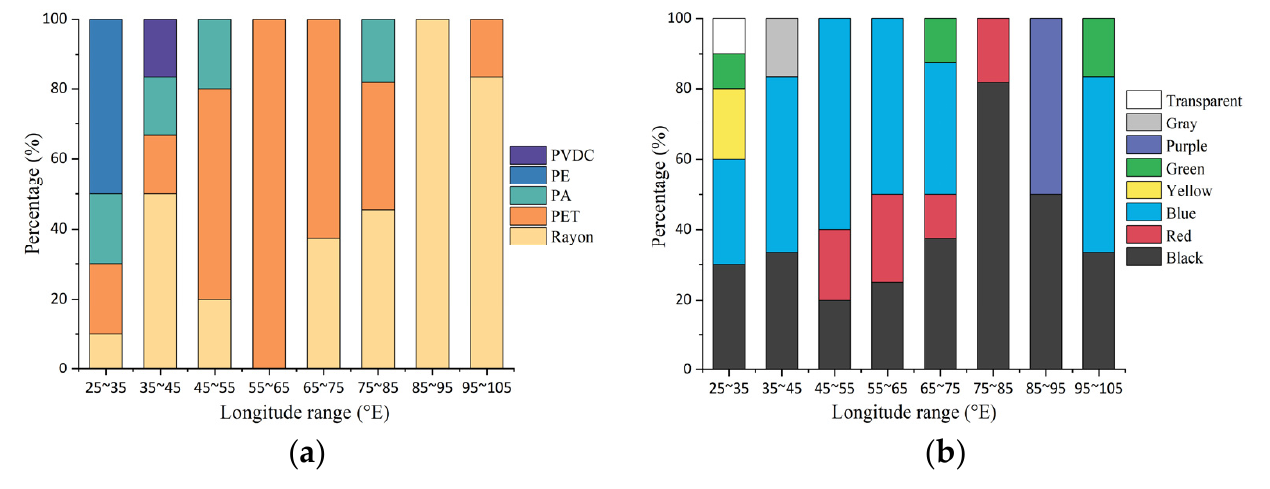
Figure 5. Polymer ( a ) and color ( b ) characteristics of microplastics.